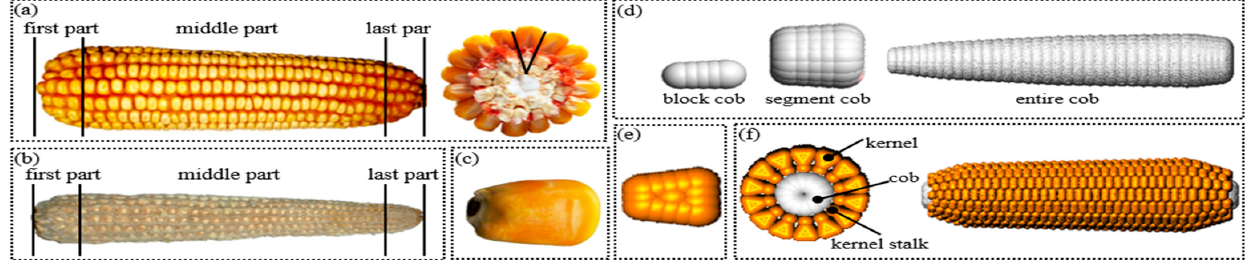
Figure 1. Corn ears discrete element modeling methods: ( a ) corn ears structure, ( b ) corn cob structure, ( c ) corn kernel structure, ( d ) corn cob discrete element model, ( e ) corn kernel discrete element model and ( f ) corn ears discrete element model.